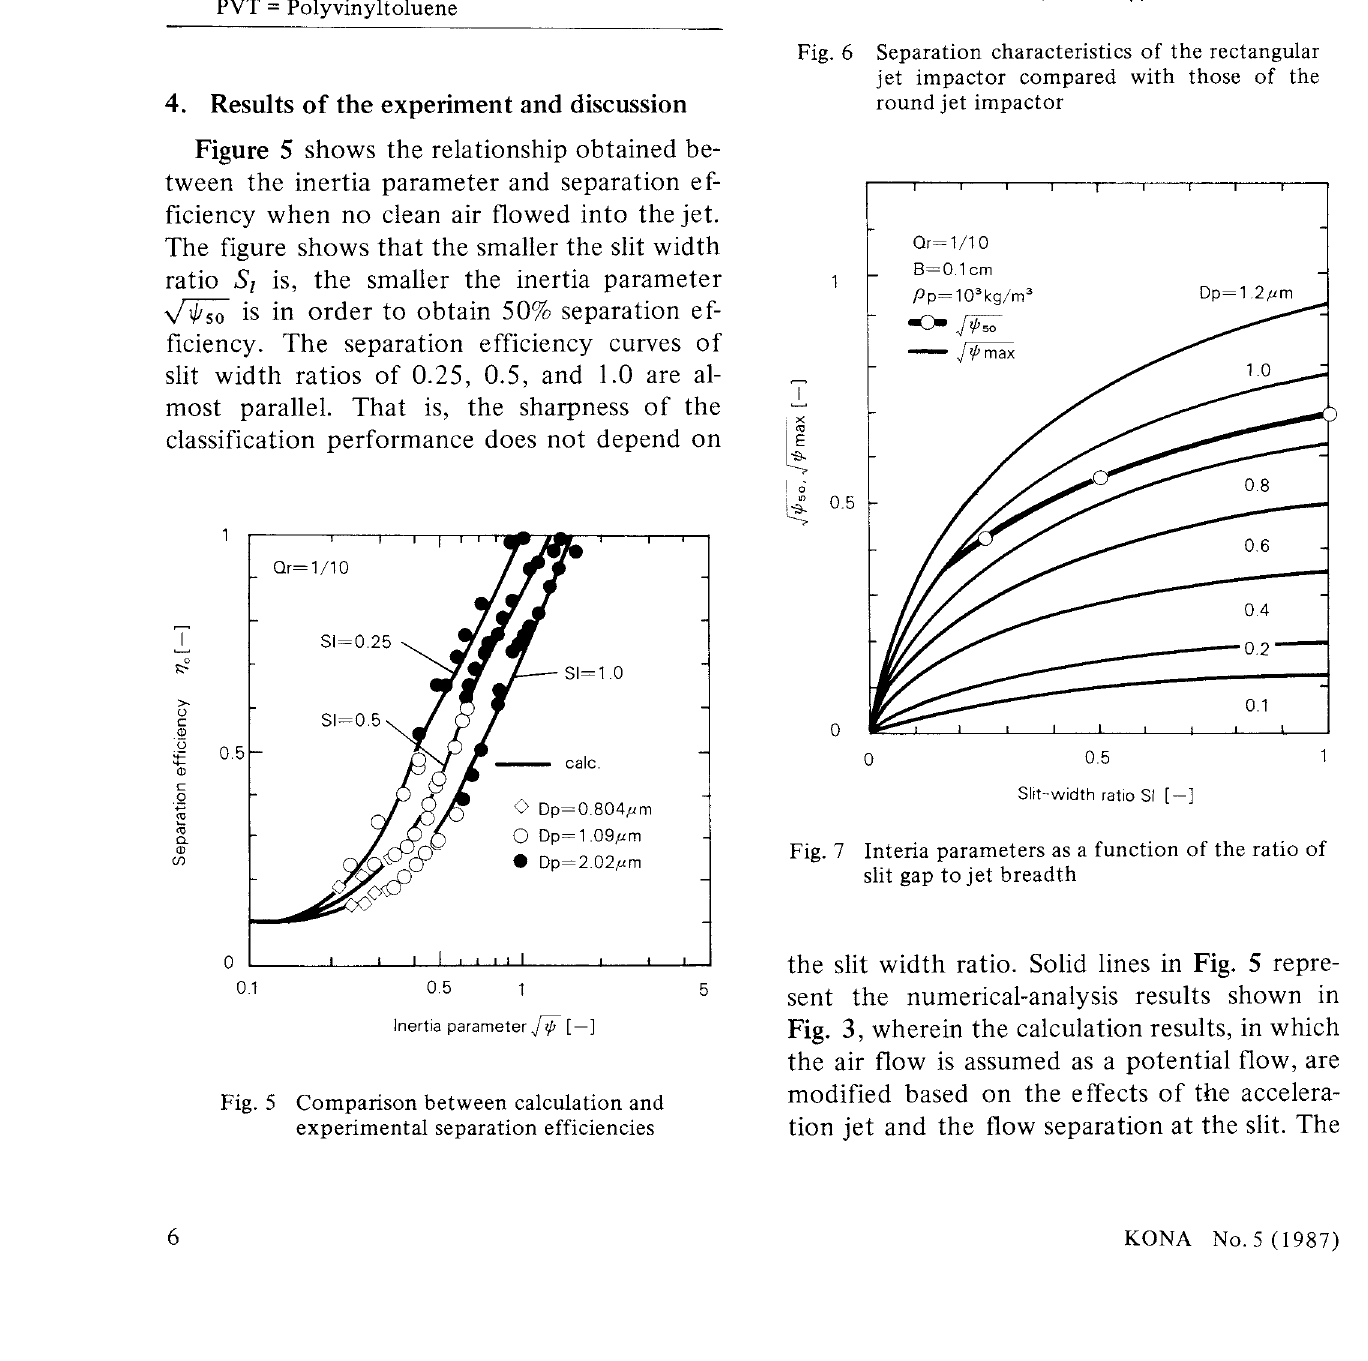
the slit width ratio. Solid lines in Fig. 5 repre sent the numerical-analysis results shown in Fig. 3, wherein the calculation results, in which the air flow is assumed as a potential flow, are modified based on the effects of the accelera Fig. 5 Comparison between calculation and tion jet and the flow separation at the slit. experimental separation efficiencies